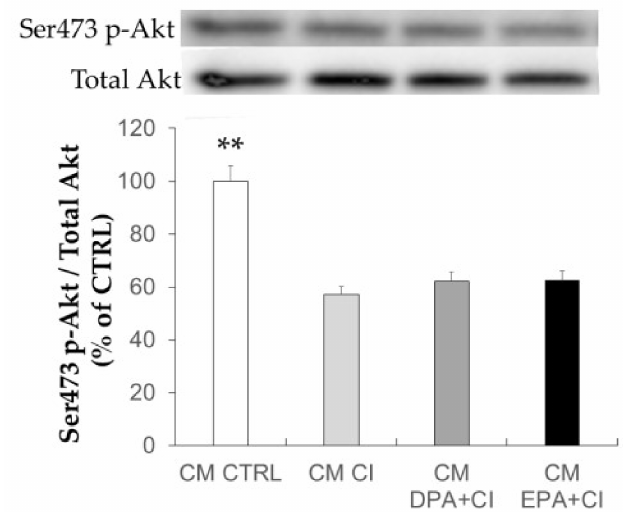
Figure 6. Effects of adipocyte condition media on Akt activation in skeletal muscle cells. Adipocyte media were collected after 48 h of treatment with, or without, 16-hour chronic insulin (CI), docosapentaenoic acid (DPA), oreicosapentaenoic acid (EPA), and after six hours of starvation. C2C12 muscle cells were treated for 16 h with conditioned media (CM). Before harvesting, cells were stimulated with insulin (100 nM) to evaluate insulin sensitivity by the quantification of Akt protein phosphorylation. Data are represented as the mean ± SEM ( n = 10 in CI and control (CTRL) groups, and n = 20 in LCn-3PUFA groups obtained after four experiments. ** p < 0.01 vs. CI obtained